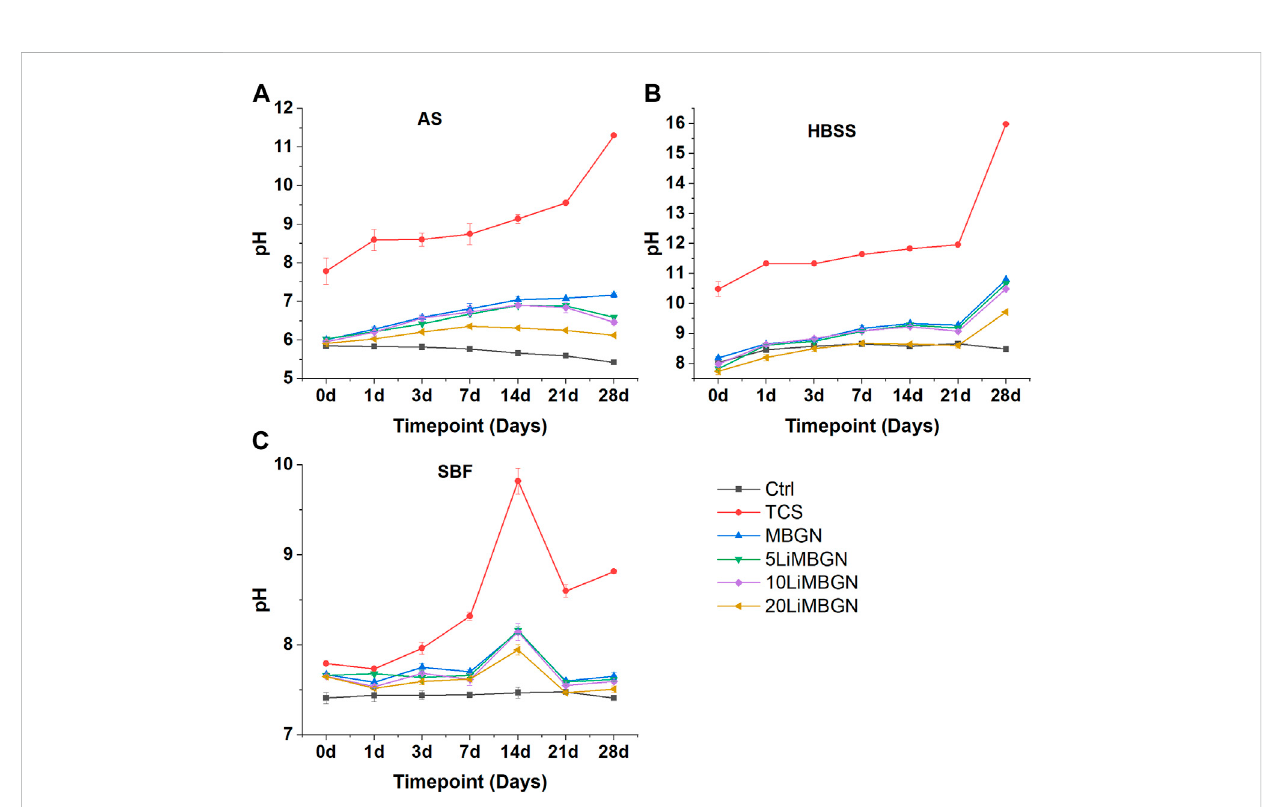
FIGURE 4 pH evolution of the fi ve particle types, as a function of time following immersion in three media — (A) in AS, (B) in HBSS and (C) in SBF.